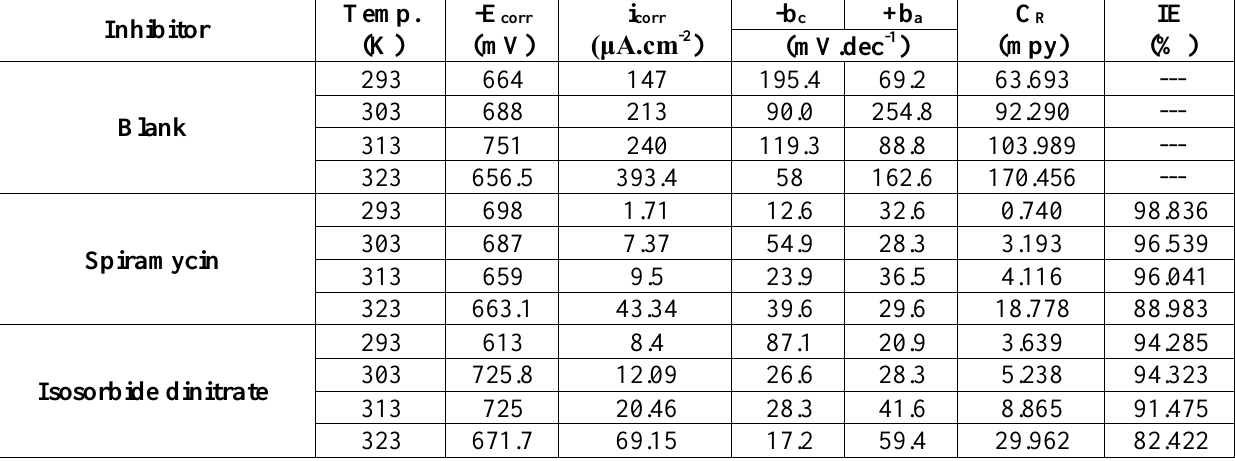
B Figure 4: Tafel plot of aluminum in HCl in the presence of (A) Spiramycin and (B) Isosorbide dinitrate at four temperatures. Table 1: Corrosion data for polarization of inhibition in HCl medium in the absence and presence of 200 ppm of two inhibitors at four